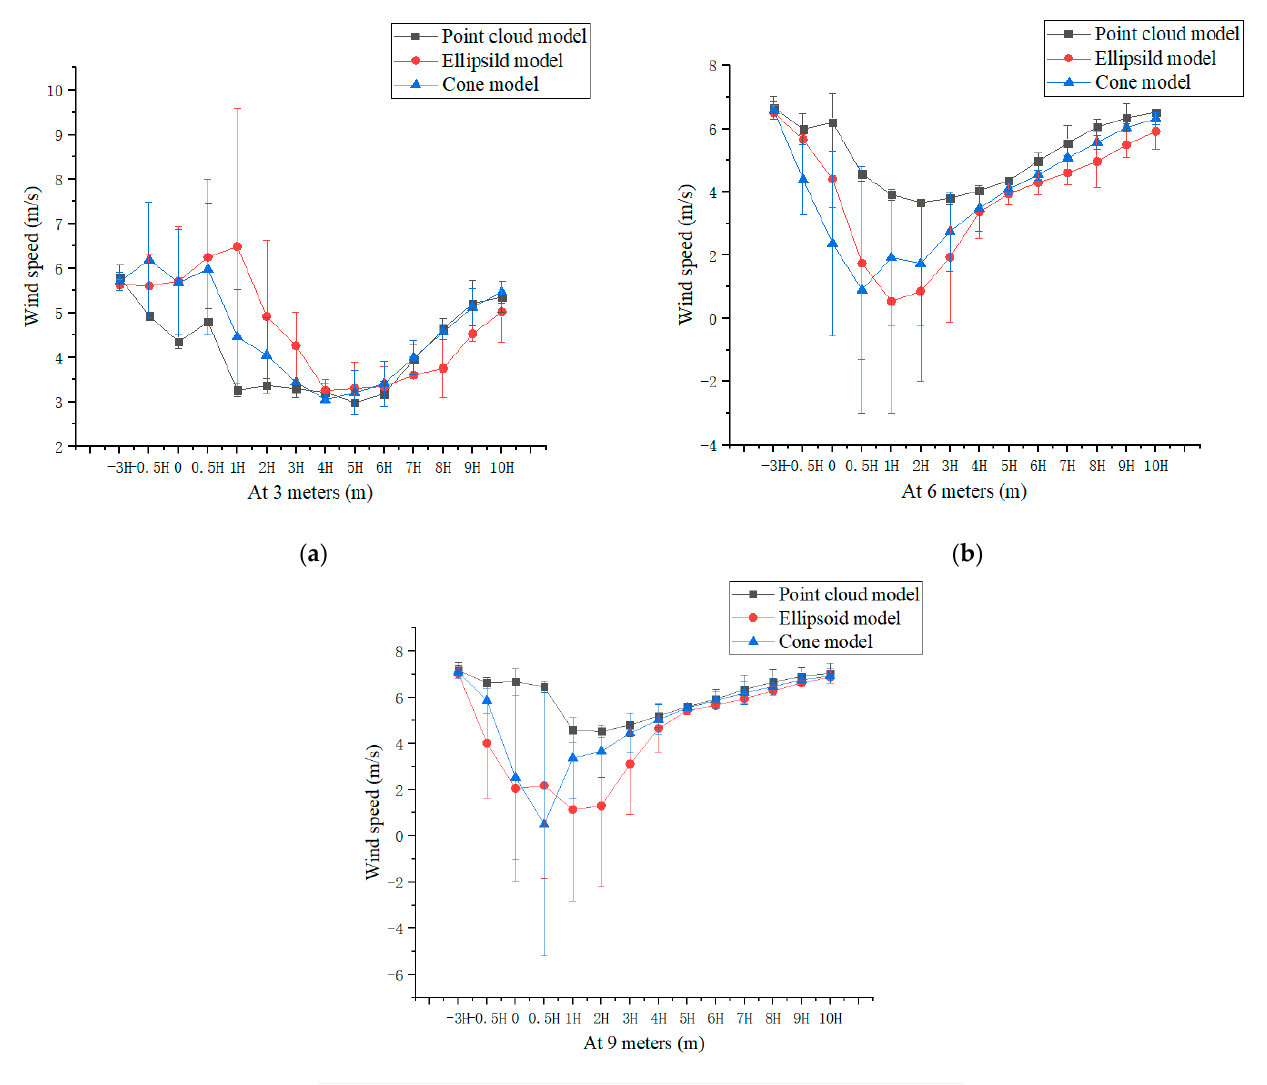
Figure 8. We compared the wind speeds obtained from simulations under different models and obtained the wind speed trends of the three models at different heights and their absolute errors with the measured results. In the three graphs, the longer the vertical lines, the larger the absolute errors. ( a ) The red line has the largest error at this height; ( b ) the blue line has a large error before the 1 H behind the forest, and the red line has a large error behind it; and ( c ) the error of the red line is the largest in all this position.